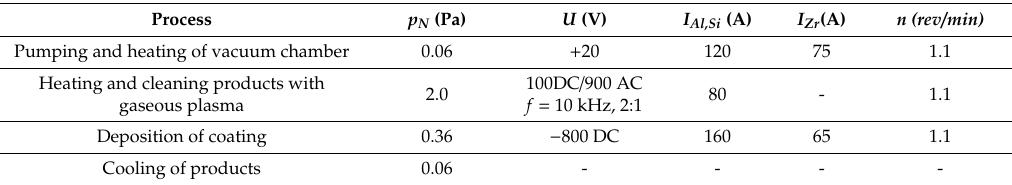
Table 1. Parameters of deposition of